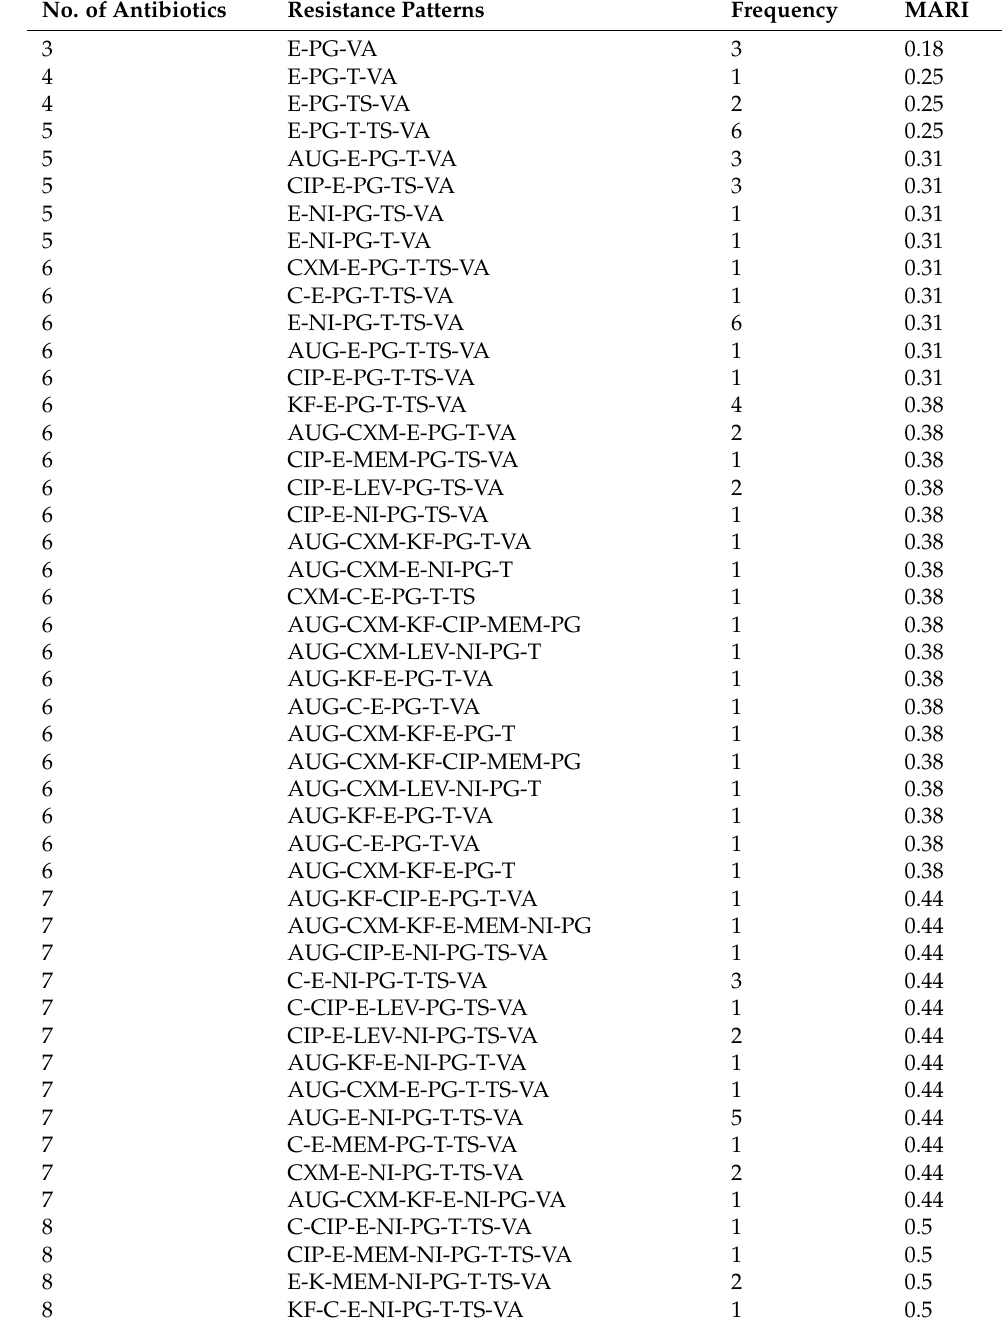
Table 1. MAR Phenotypes of Listeria monocytogenes